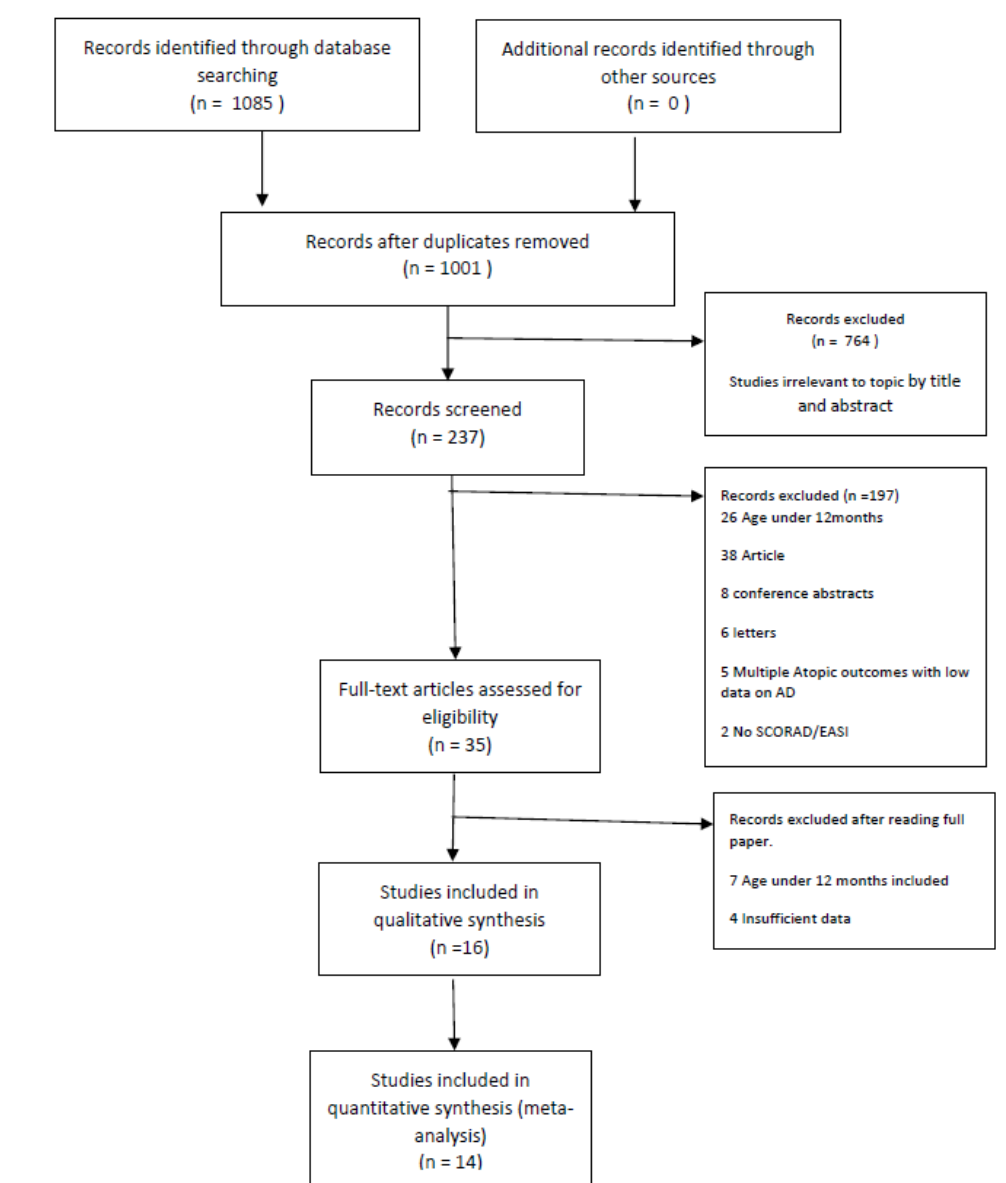
Figure 1. PRISMA 2009 Flow Diagram to show results of the search process and inclusions/exclusions.